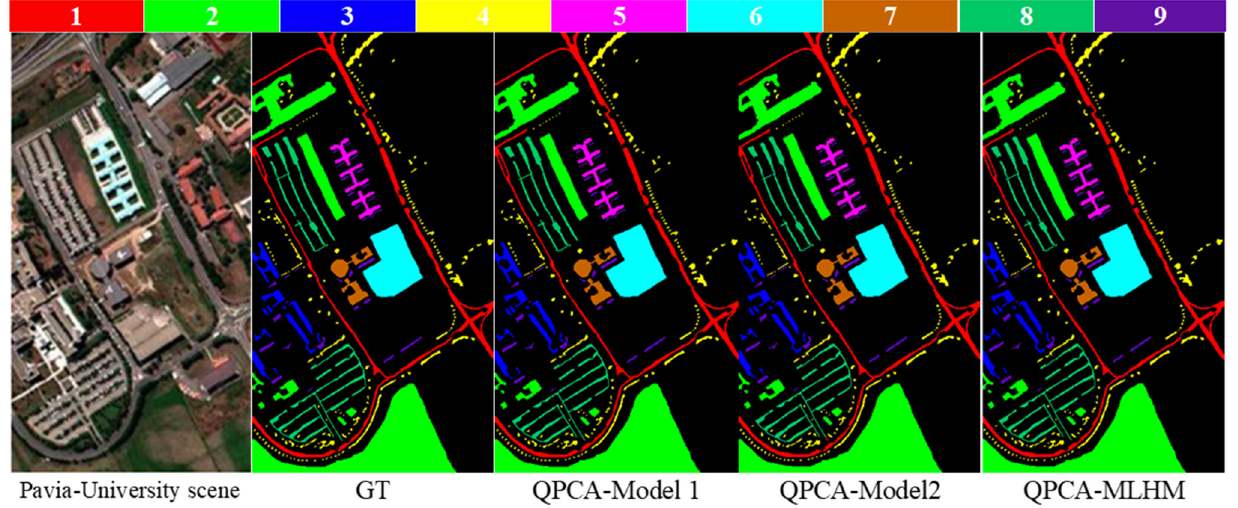
Figure 5. The results of both levels models for the Pavia-University dataset. Table 5. The sample number of level-0 and level-1 datasets. It also indicates the two level-0 models’ results and the final results of the level-1 model for the KS_center dataset.